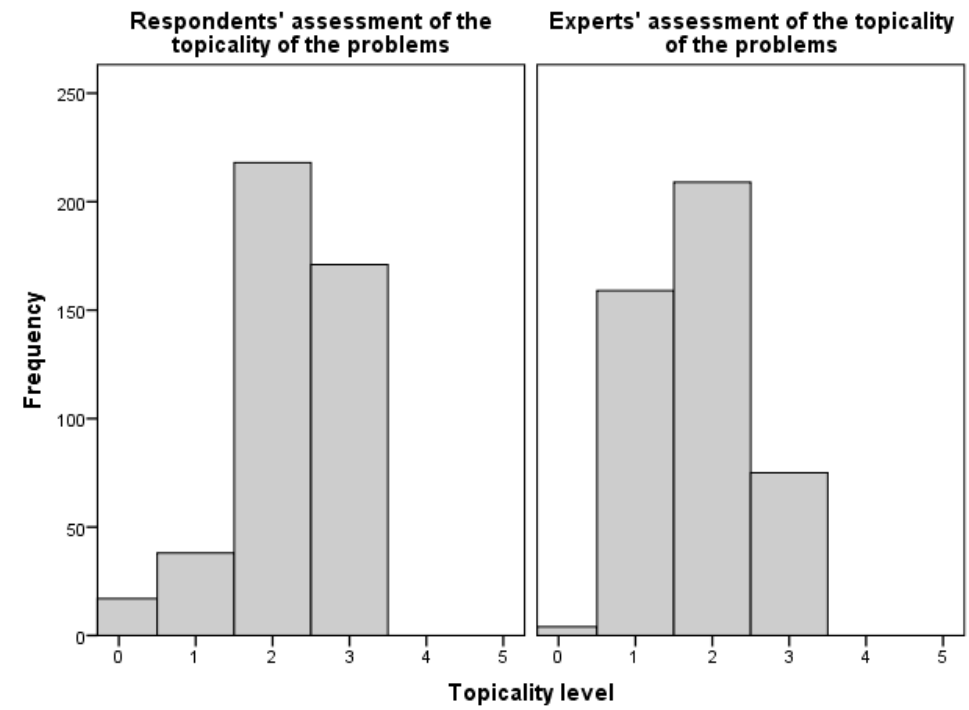
Figure 3. Histograms of topicalities of the problems assessed by the respondents and the